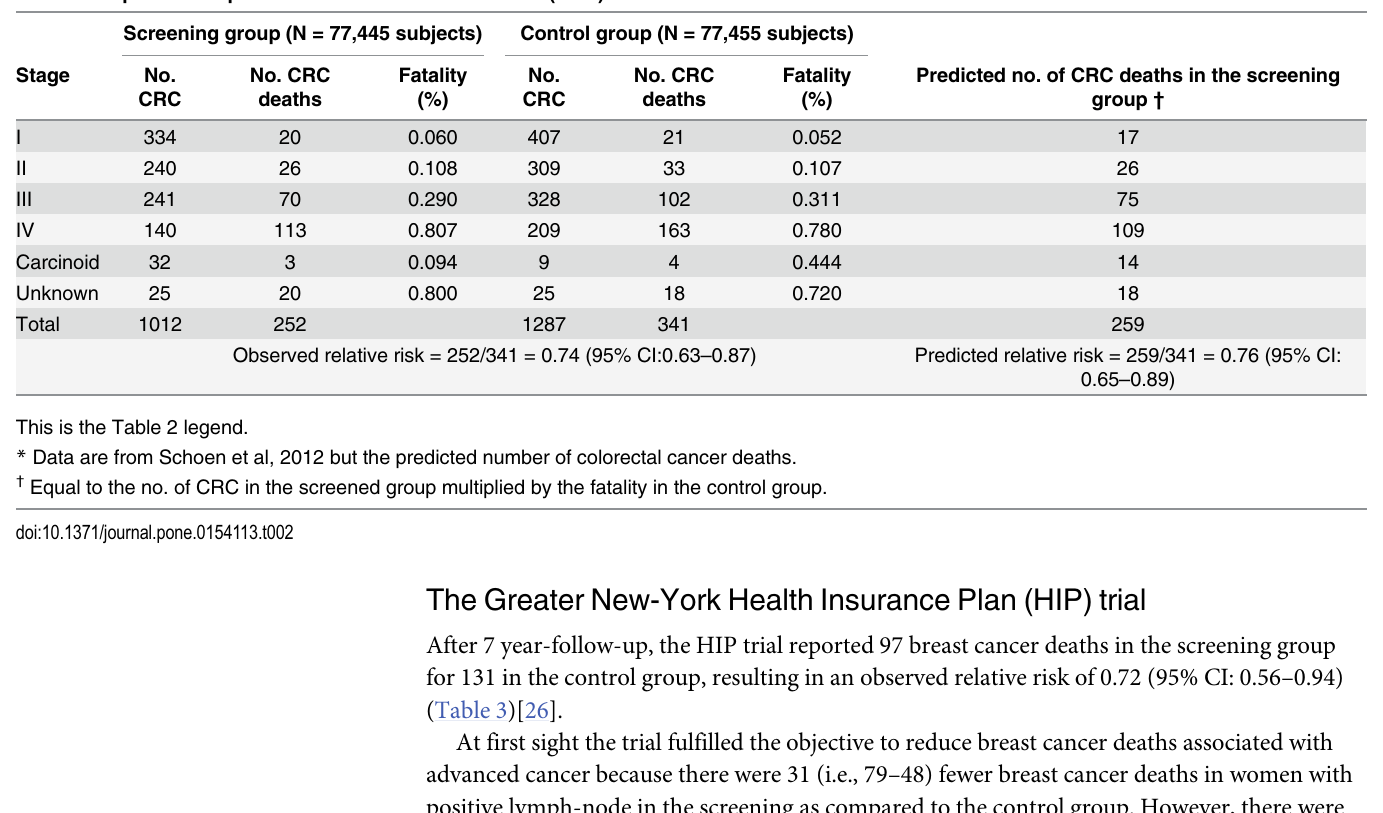
for 131 in the control group, resulting in an observed relative risk of 0.72 (95% CI: 0.56 – 0.94) (Table 3)[26]. At first sight the trial fulfilled the objective to reduce breast cancer deaths associated with advanced cancer because there were 31 (i.e., 79 – 48) fewer breast cancer deaths in women with positive lymph-node in the screening as compared to the control group. However, there were only 19 (i.e., 121 – 102) fewer women with positive lymph-node in the screening as compared to the control group. So, the number of breast cancer deaths among lymph-node positive women